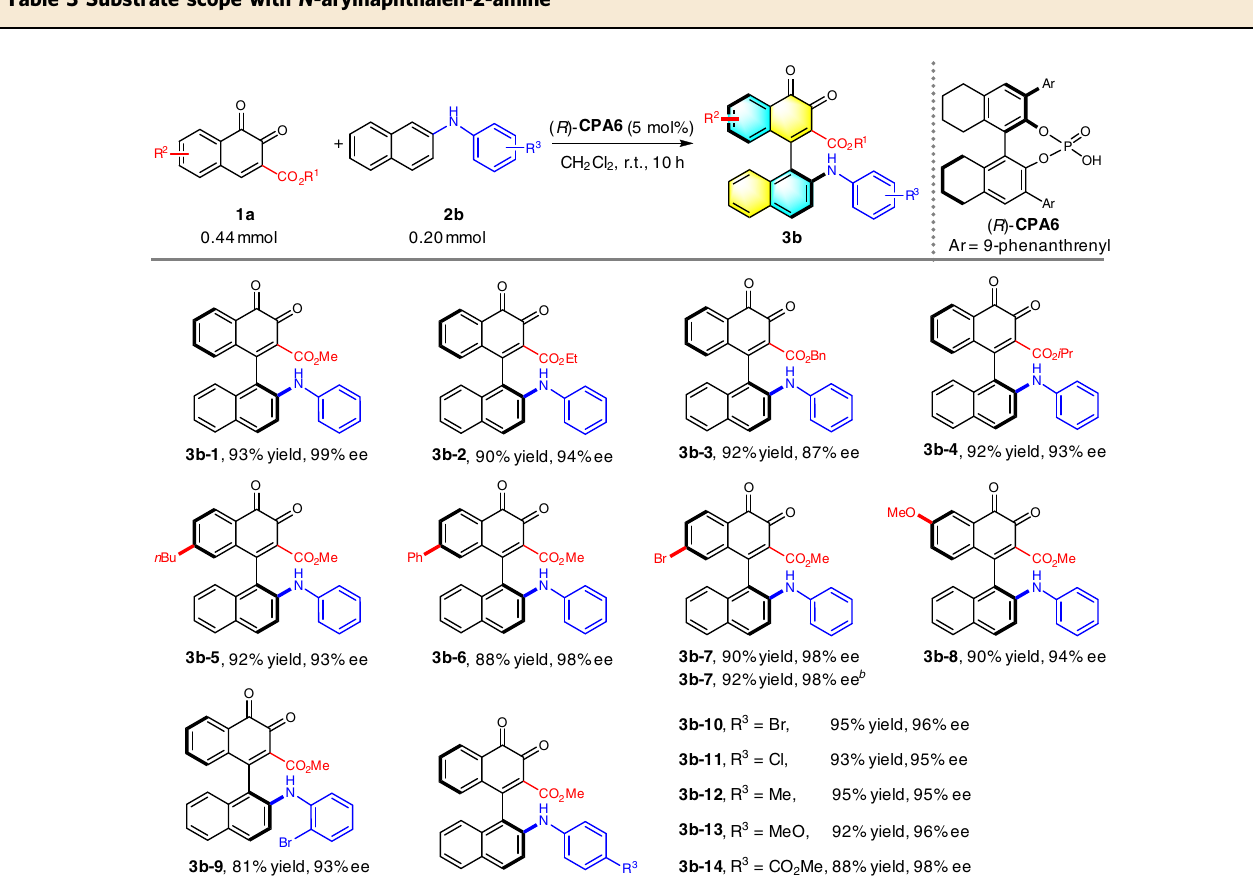
Table 3 Substrate scope with N -arylnaphthalen-2-amine a